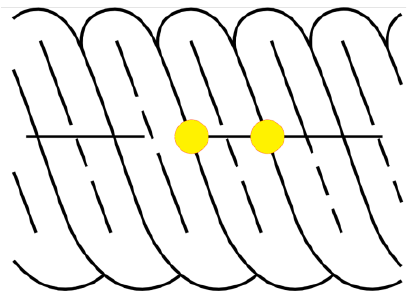
Figure 13. Yarn twist step (Adapted from [18]).